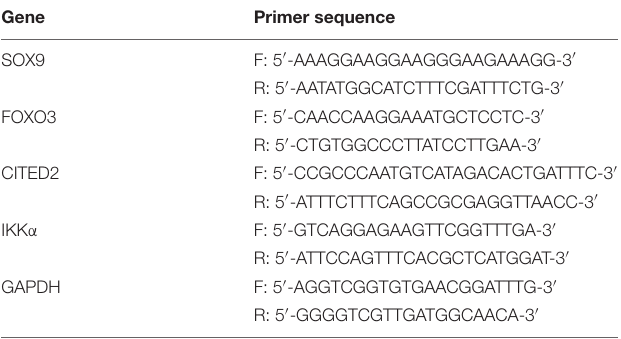
TABLE 1 | Primer sequences for